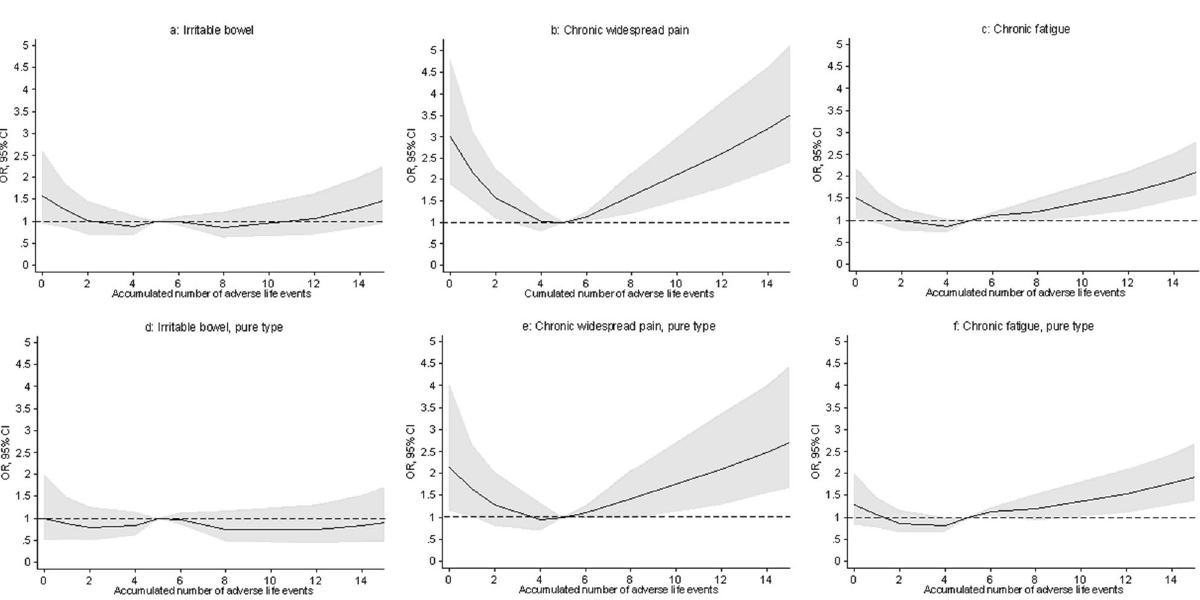
Figure 2. Association between the accumulated number of adverse life events and single-organ subtypes of functional somatic disorders. Cases were established by means of both self-reported questionnaires and diagnostic interviews. ( a ) Was adjusted for sex and age; ( e ) was not adjusted; ( b–d,f–h ) were adjusted for sex, age, social status, personality, and self-efficacy. NB! The OR scales for the cardiopulmonary types ( a,e ) have different ranges than the OR scales for the other types.